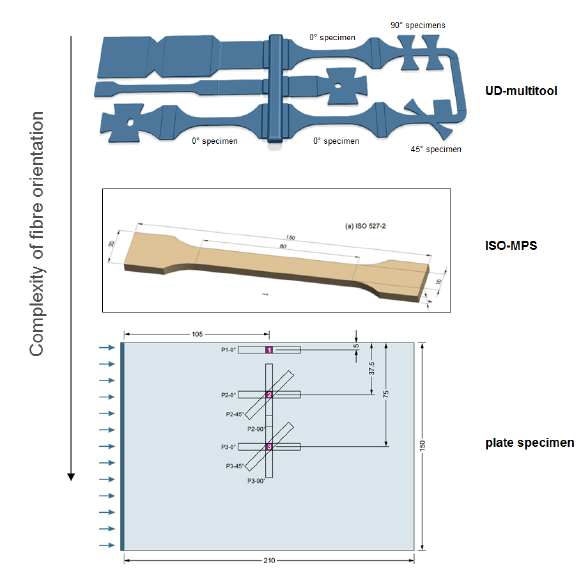
Figure 1. Overview of different